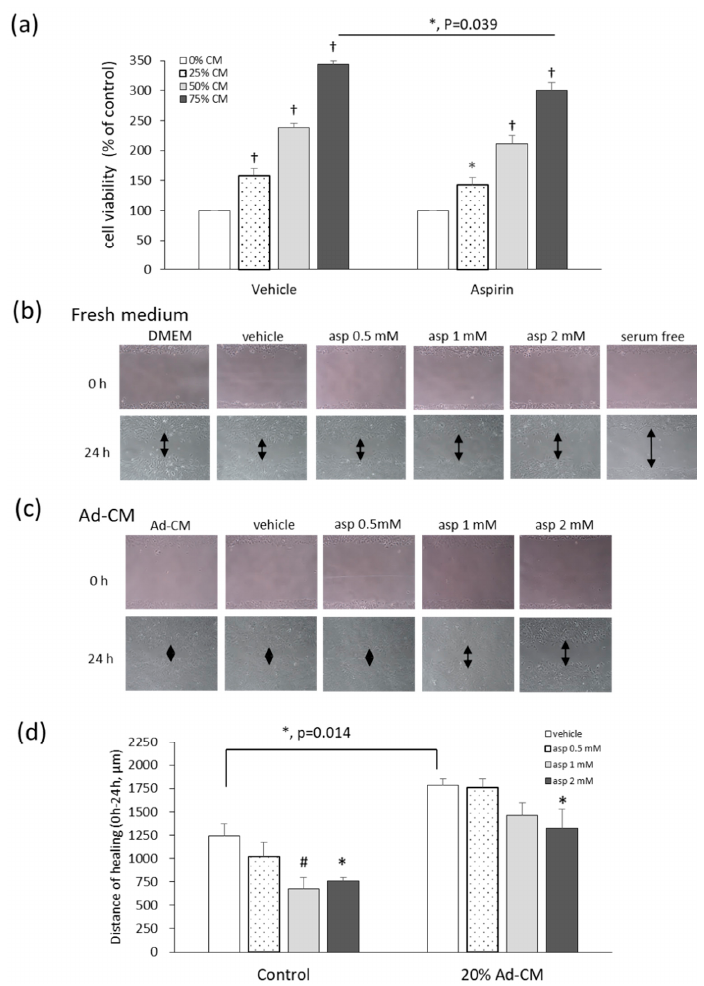
Figure 4. Aspirin suppresses cell growth and migration of 4T1 cells cultured in obese-associated models. ( a ) 4T1 cells were treated with or without 1 mM aspirin, and cultured in di ff erent percentages of adipocyte-conditioned medium (Ad-CM) for 72 h. Cell viability was analyzed by the methylthiazole tetrazolium (MTT) test. Migration patterns were observed in the scraped distance of 4T1 cells treated with or without aspirin for 24 h and incubated in ( b ) fresh medium 3% fetal bovine serum (FBS) or ( c ) 20% Ad-CM. The morphology of 4T1 cells was observed microscopically at 100 × magnification. ( d ) The distance of healing was quantified by manual measurement under the microscope. The assay was performed with at least three independent experiments. Data are presented as mean ± SEM. Statistical analysis was done by one-way ANOVA and the LSD post hoc test. Significant di ff erences are presented as * p < 0.05, # p < 0.01, or † p < 0.001 vs. vehicle